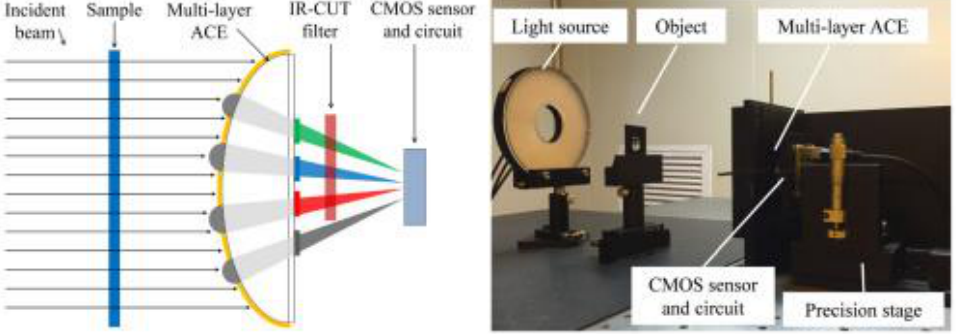
Figure 44. Optical configuration of the MSI system.